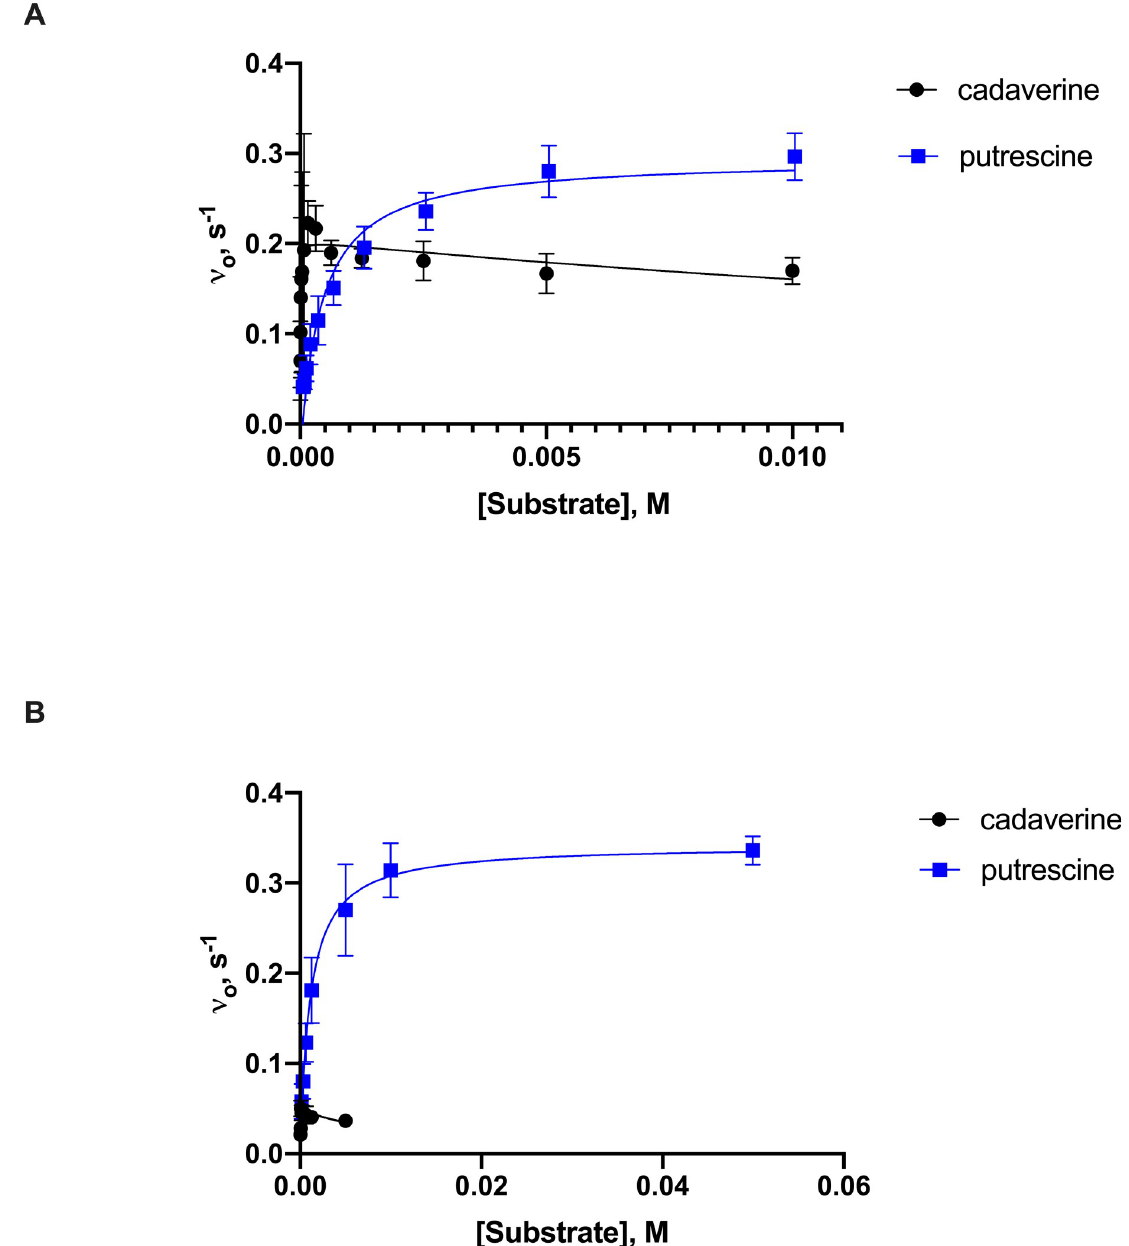
Fig 3. Representative steady-state kinetics of Ss DesB in oxygen consumption and product formation assays. A. Initial rate kinetic data obtained with cadaverine and putrescine in oxygen consumption assays. Kinetic data for putrescine assayed with Ss DesB, 0.05 mM FAD, and 0.7 mM NADPH. These data were obtained in triplicate and fit to the Haldane substrate inhibition (cadaverine) and Michaelis- Menten equations (putrescine), respectively. B. Initial rate data for cadaverine and putrescine assayed with Ss DesB, 0.05 mM FAD, and 0.7 mM NADH in product formation assays. These data were obtained in triplicate and fit to the Haldane substrate inhibition (cadaverine) and Michaelis-Menten equations (putrescine), respectively. molecule in the asymmetric unit contained bound FAD and in the Ss DesB-FAD-NADP + com- plex, a bound NADP + molecule was clearly resolved in each protomer. Based on a query of the Protein Data Bank (PDB) using PDBefold [41, 42], the overall structure of the Ss DesB resem- bles those of previously determined crystal structures of the flavin-dependent monooxygenases